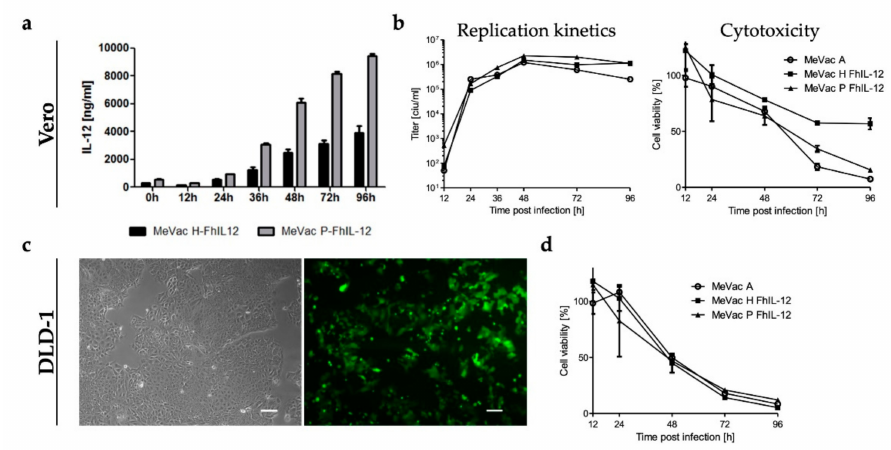
Figure 8. Oncolytic measles vaccine vectors encoding a human IL-12 fusion protein. ( a ) Vero cells were infected at an MOI of 3 and FhIL-12 in cell culture supernatants was quantified by ELISA. ( b ) Left panel: To generate one-step growth curves, Vero cells were infected at an MOI of 3 and viral progeny at designated timepoints were quantified by titration assay. Right panel: XTT cell viability assay was performed after infection of Vero cells at an MOI of 1. ( c ) DLD-1 human colon cancer cells were subjected to mock treatment (left panel) or inoculated with MeVac ld EGFP at an MOI of 1. Images were acquired 48 h after inoculation. Scale bars: 100 µ m. ( d ) DLD-1 cells were inoculated with indicated MeVac variants at an MOI of 1 and cell viability was determined by XTT assay at designated timepoints. Cell viability data is presented as a percentage of mock (100%). Mean and standard deviation of triplicate samples are